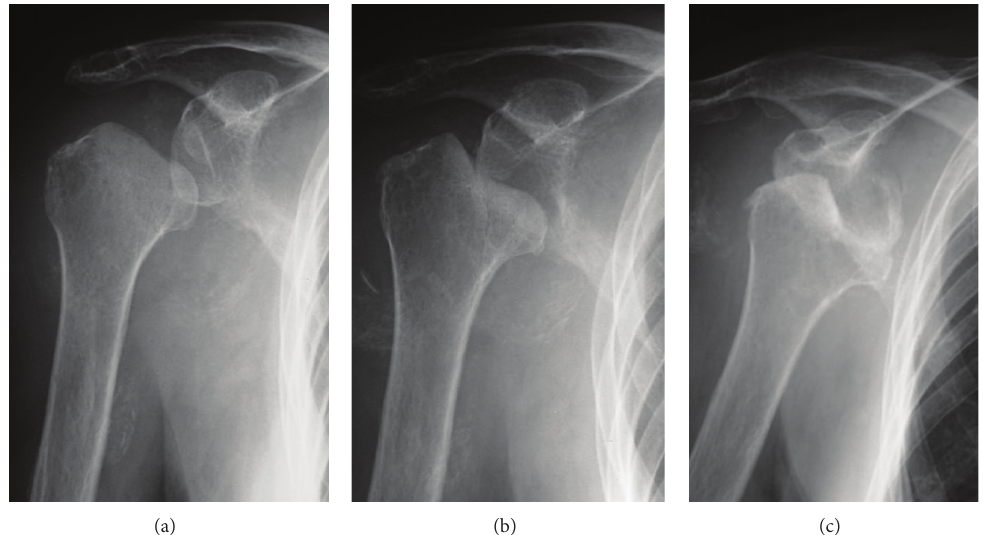
Figure 1: Case 1. Serial preoperative radiographs. (a) At the first visit, the humeral head shows a minor collapse. (b) Three weeks later, the collapseofthehumeralheadhasprogressed.(c)Fourmonthslater,thedestructionoftheshoulderisfurtherprogressed,includingtheglenoid.